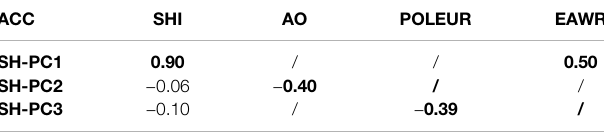
TABLE 1 | Correlation coef fi cient of Siberian High intensity index (SHI), AO, POLEUR, and EAWR teleconnection indices with the PCs of SH modes. The bold italic font indicates the value exceeding the 95% con fi dence